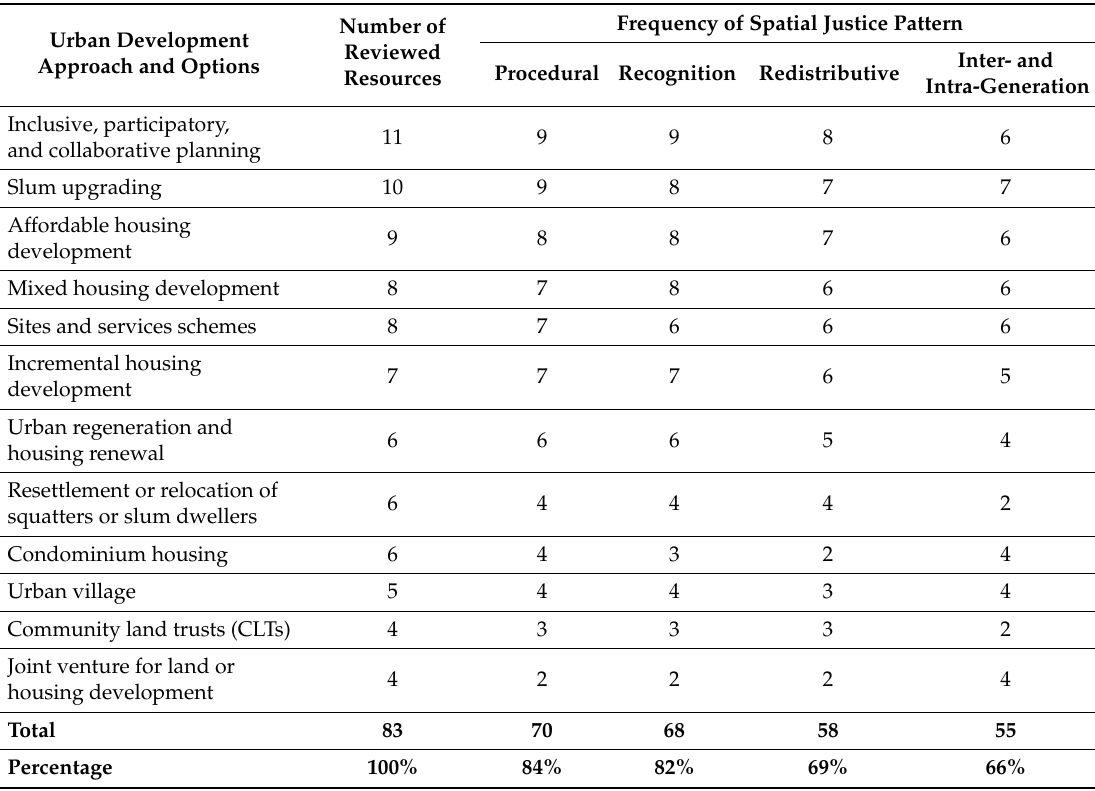
Table A1. Cross analysis of the forms of spatial justice and main urban development